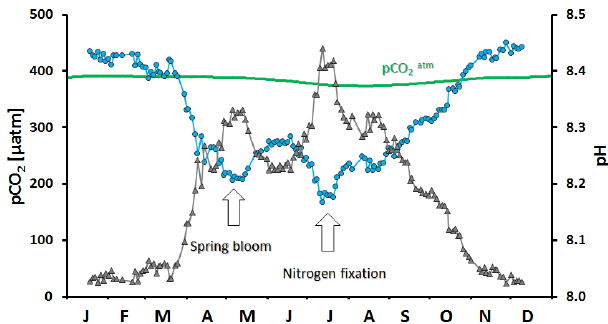
Figure 5. Typical seasonality of pCO 2 in surface water (blue line) and the atmosphere (green line) in the Eastern Gotland Sea modified after Schneider (2011) and presented together with pH calculated from the shown pCO 2 data and the mean A T